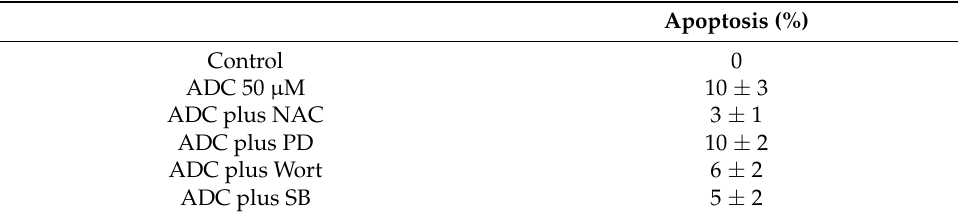
Figure 6. The effect of antrodin C (ADC) on cell death and cell-cycle-related proteins, and ERK/AKT/p38 MAPK pathways in HCT-116 cells. ( A , B ) The protein levels of Bcl-2, Bax, caspase-3, caspase-9, cyclin D1, CDK2, cyclin E, TNF α , ERK, AKT, and p38 were determined using Western blotting in ADC-treated HCT-116 cells. While β -actin served as an internal control, densitometric analysis was used to quantify protein levels with the control at 100%. Data are expressed as the mean ± SD of three independent experiments. * p < 0.05, compared with the control group. Table 1. The effects of kinase inhibitors in blocking antrodin-C (ADC)-induced cell death.